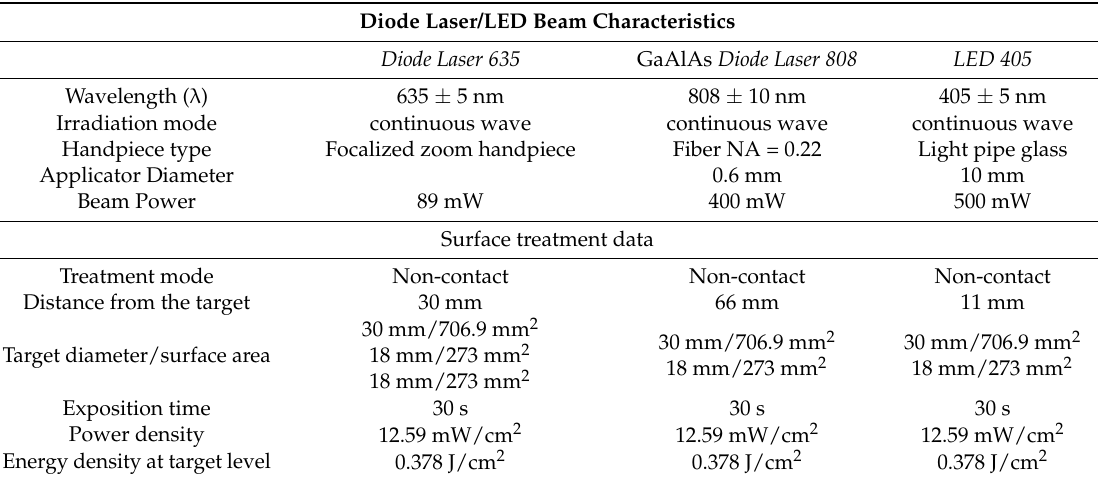
Table 1. Light sources and irradiation